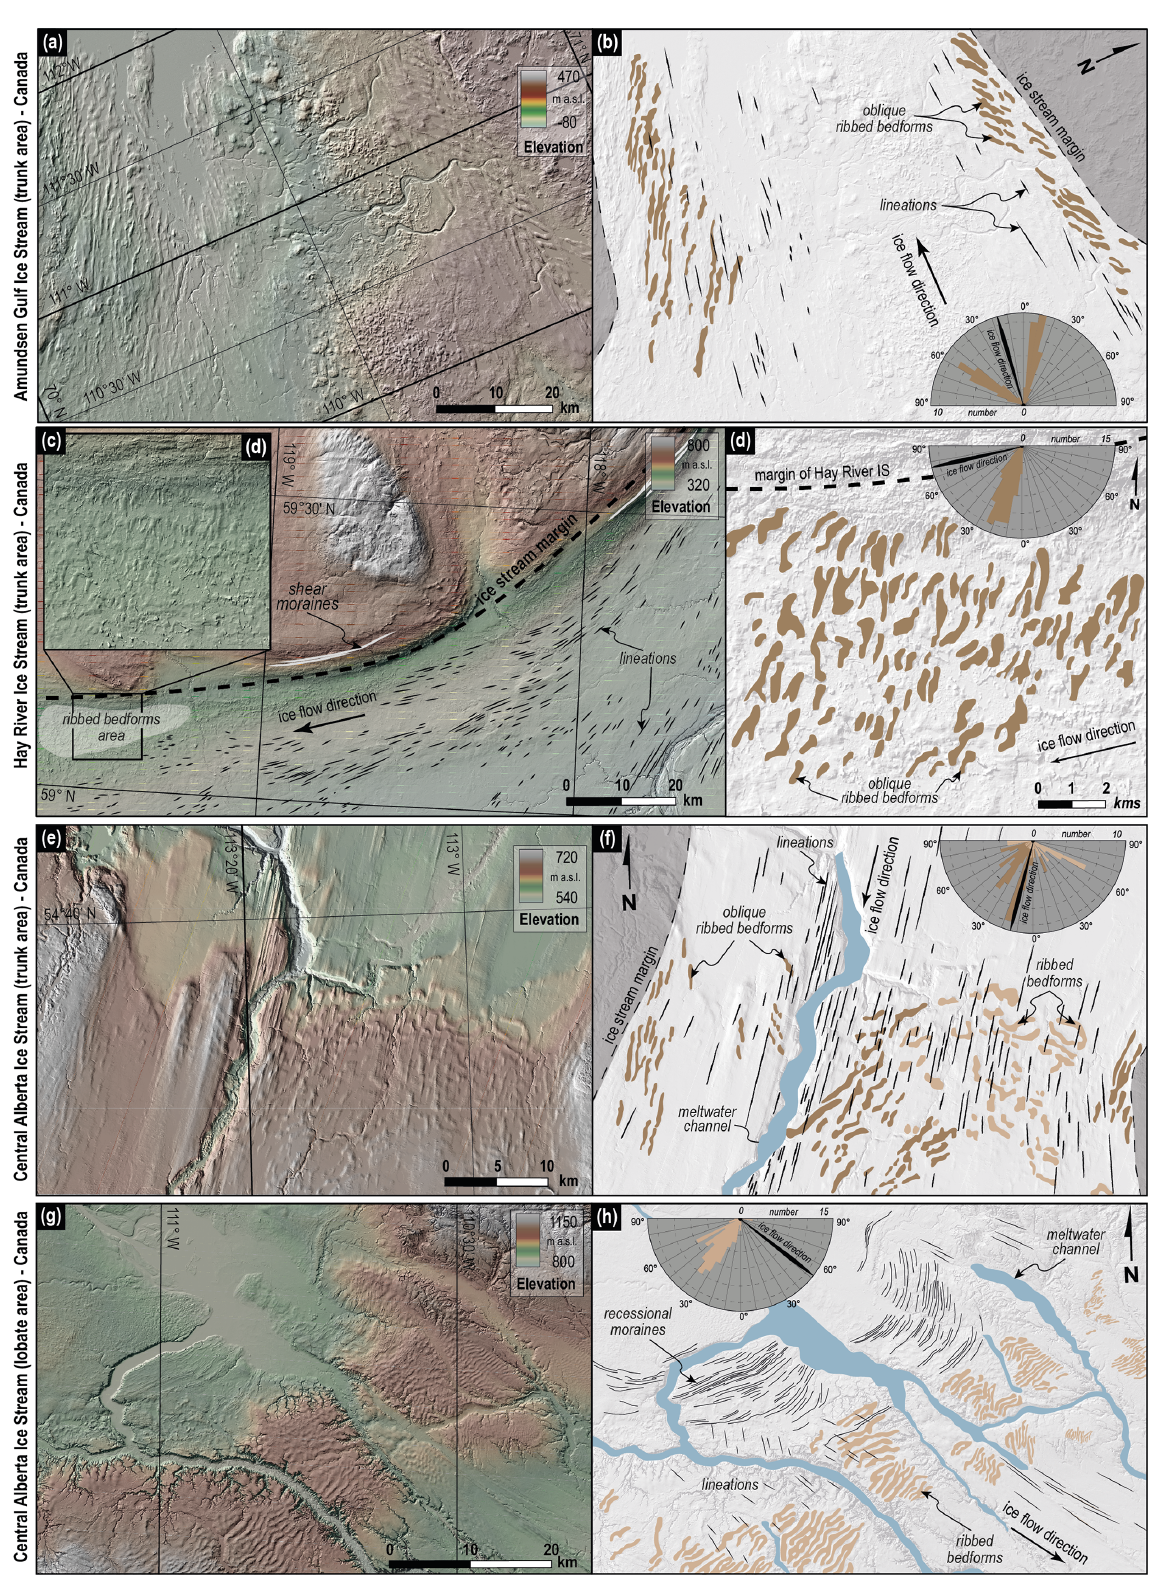
Figure 12. Manual mapping of ribbed bedforms, lineations and ice stream margins along different palaeo-ice stream tracks in Canada. Left panels show digital elevation models and hillshade maps using ArcticDEM database (Porter et al., 2018) and lidar data (Alberta Geological Survey). Right panels show our morphological interpretations and the rose diagrams compiling bedform